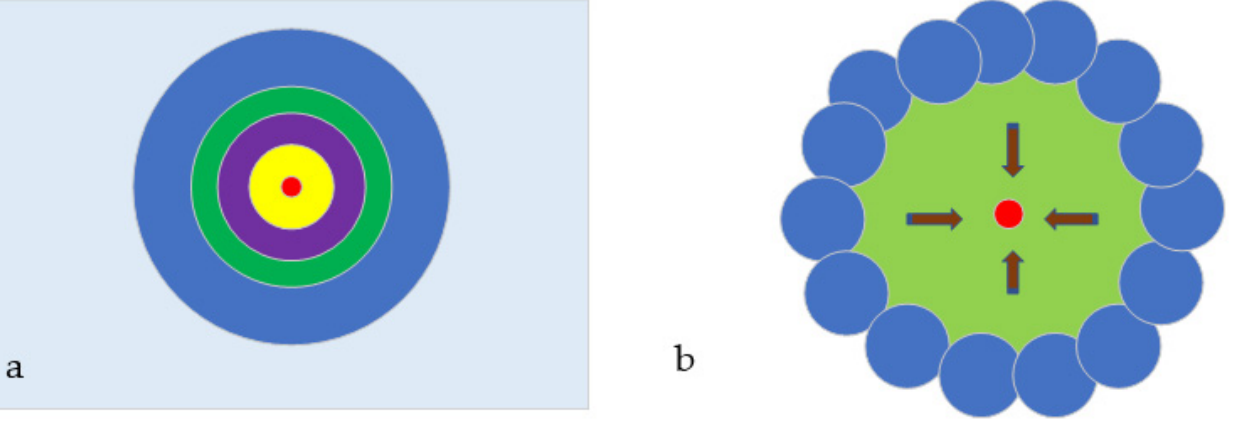
Figure A17. Conceptual model for a hydrodynamic stationary mound. ( a ), Example of radial head changes as a function of abstraction or injection. red = injection well, P wf ; light blue = aquifer head, P e ; blue, green, purple and yellow = different values of P between P e and P wf . ( b ), Conceptual model for a stationary plume (green), where blue circles indicate areas where P e - P wf > P e is associated with injection or infiltration; red circle is abstraction well. Arrows indicate fluid flow directions within the plume. The blue ring of infiltration/injection devices creates a zone of high potential surrounding the contaminant plume. The full width of the hydrodynamic stationary plume is schematically illustrated in Figure